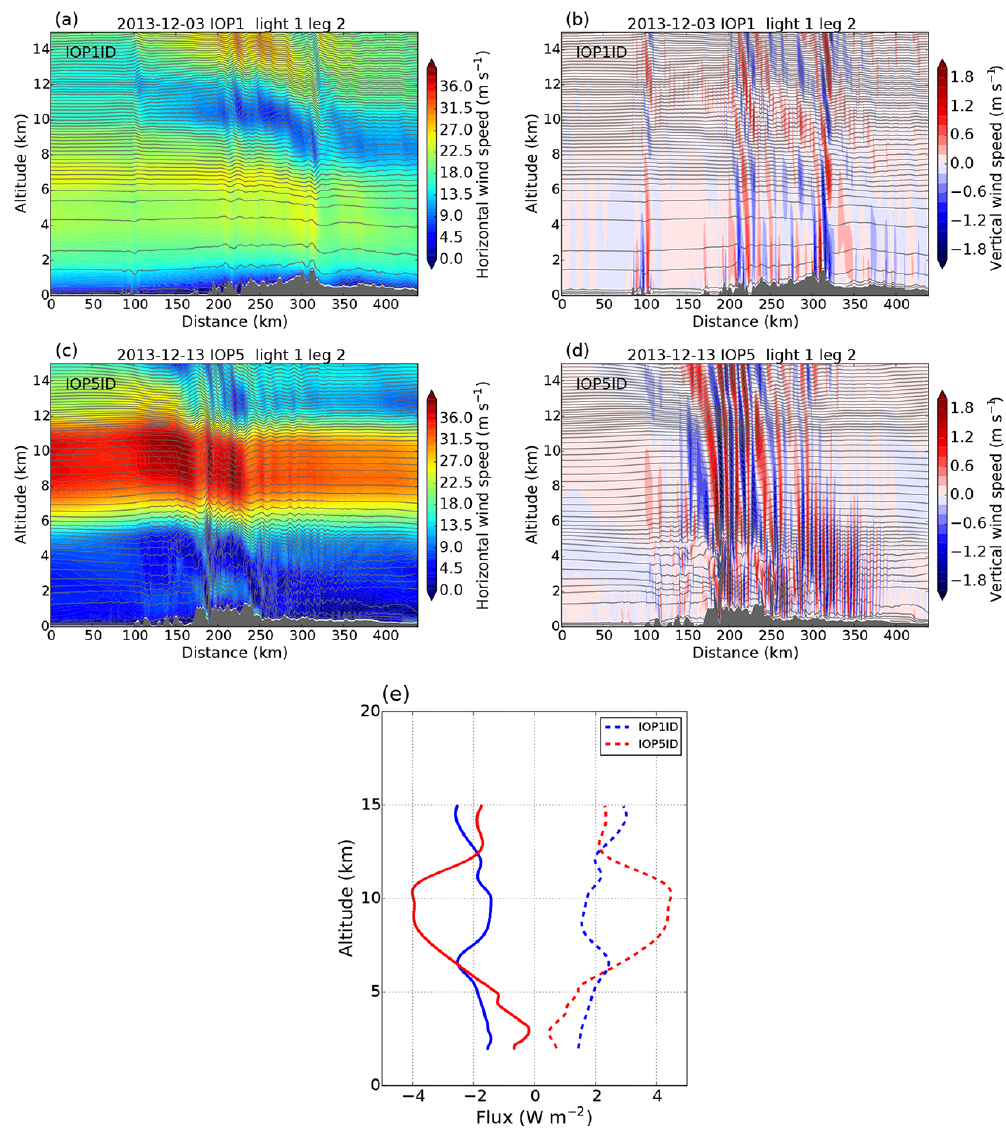
Figure 9. Cross sections of idealized 2-D simulations (IOP1ID and IOP5ID) for horizontal and vertical wind speed along leg 2 of flight 1 during (a, b) IOP1 and (c, d) IOP5. Profiles of EF (dashed lines) and MF (dotted lines) are plotted in panel (e) . Simulations were initialized with upstream profiles shown in Fig. 8 for horizontal wind